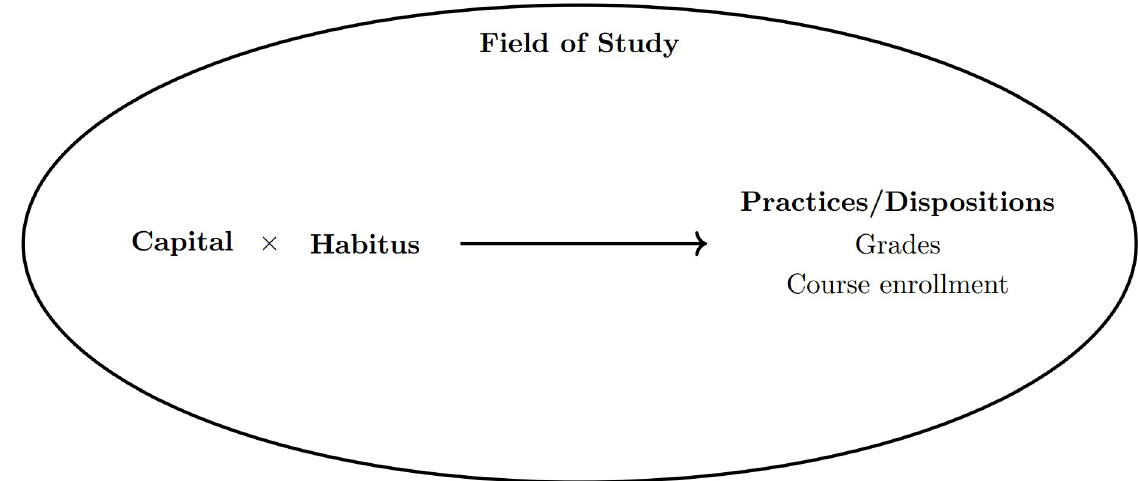
Fig 1. Simplified Bourdieusian theoretical model. The Bourdieusian framework used in the current study is adapted from the original model outlined by Bourdieu [22] and the work of Archer and colleagues. [29–31]A student’s habitus interacts with their acquired level of capital (in particular science-related capital) to generate a student’s practices (behaviours, grades etc.) and their dispositions towards the field. A student’s habitus, a matrix of internal dispositions [32], is formed in relation to the specific socio-cultural and historical context of a field. A student who is positively predisposed to study in a scientific field, whilst also having access to various forms of science-related capital, will likely achieve higher grades in that field and aspire to study in that field in the future. A student who encounters bad experiences in the field will likely be dissuaded from future study via their habitus (‘this discipline is not for me’).